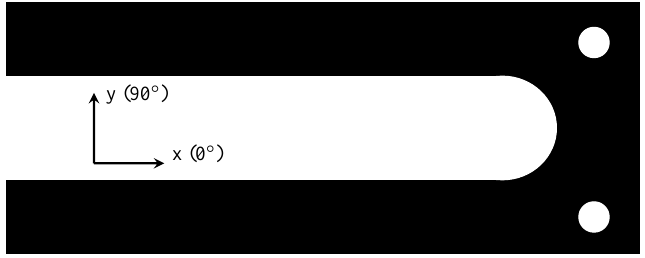
Figure 23. Shape of the middle blade of MyFlex- γ